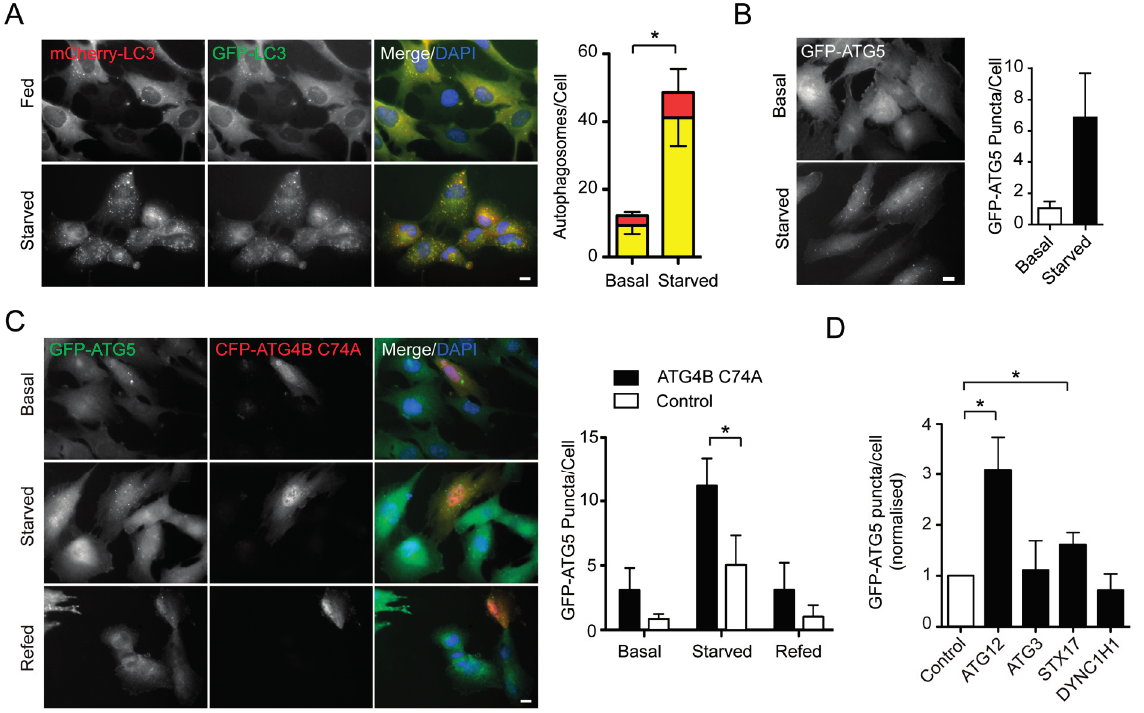
Figure 1. Tandem LC3 RPE1 cells and GFP-ATG5 RPE1 cells are useful reporters for altered autophagosome assembly kinetics. ( A ) Example of a basic assay for starvation-induced autophagosome assembly using RPE1 cells stably expressing mCherry-GFP-LC3B. Images to the left; quantitation of a standard starvation experiment to the right Yellow bars represent red/green autophagosomes; red bars represent red-only autolysosomes (basal = fed; upward error bars are SD of the red-only puncta and downward error bars are SD for green/red puncta; t -test * p < 0.05 for both elements); ( B ) Example of a basic assay for GFP-ATG5 puncta numbers in fed (basal) and amino acid/growth factor starved RPE1 cells (images to the left; quantitation to the right); ( C ) Increased steady state GFP-ATG5 puncta in cells expressing dominant-negative autophagy mutant, ATG4B C74A (images to the left; quantitation to the right; t -test * p < 0.5); ( D ) GFP-ATG5 puncta counts in starved cells silenced for ATG12, ATG3, STX17 or DHC1 ( t -test * p < 0.5). Scale bars = 10